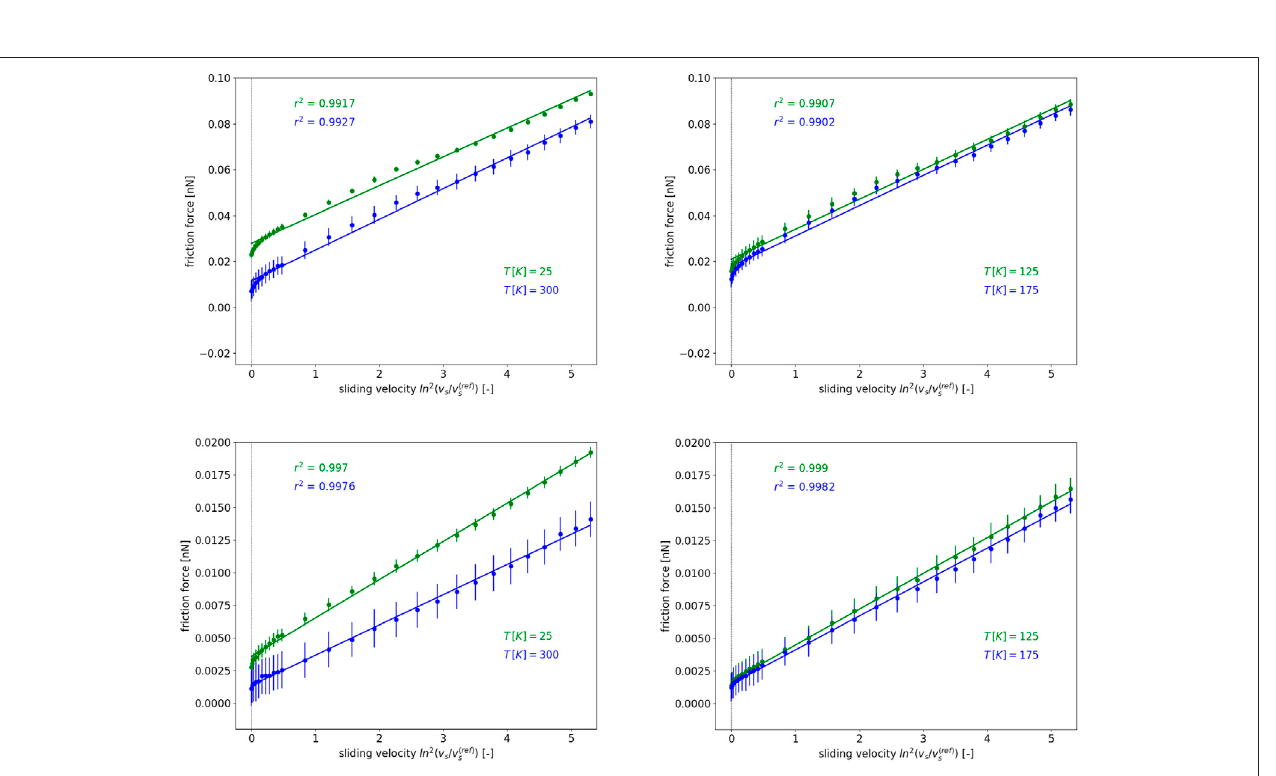
Frontiers in Mechanical Engineering |